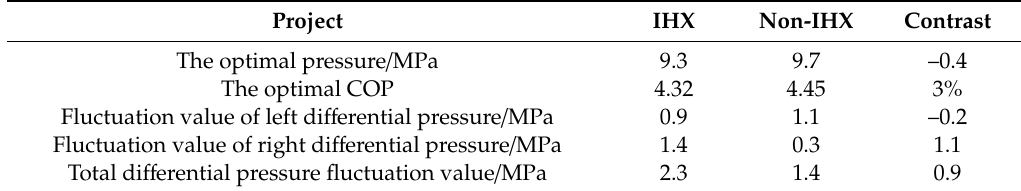
Table 2. Comparison of optimal exhaust pressure and COP of a heat pump with or without internal heat exchanger